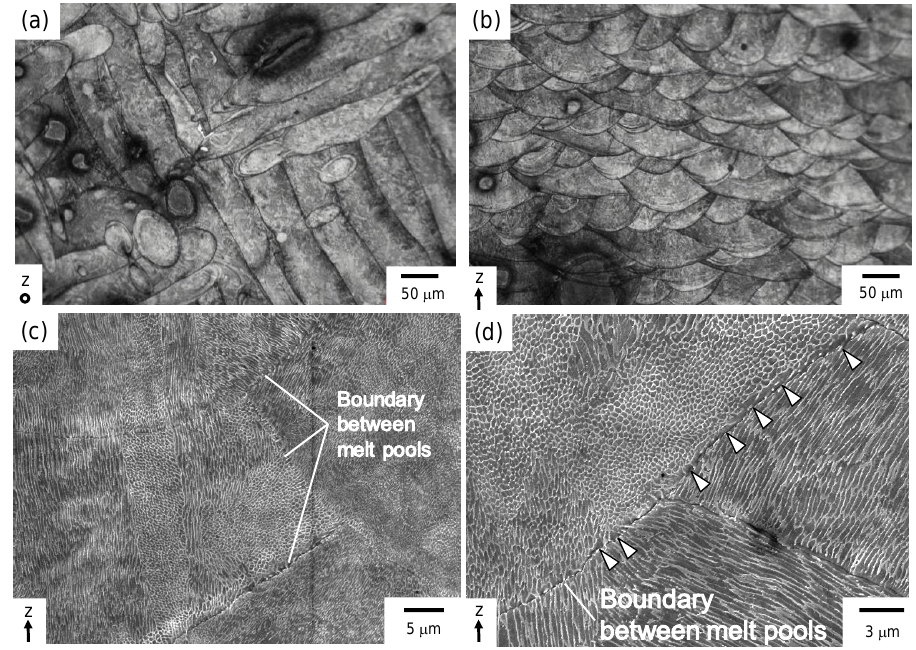
Figure 3. ( a , b ) optical micrographs, ( c , d ) SEM image showing microstructure of the maraging steel fabricated by selective laser melting of power bed metal, which were observed from ( a ) z direction and ( b – d ) normal to z direction.